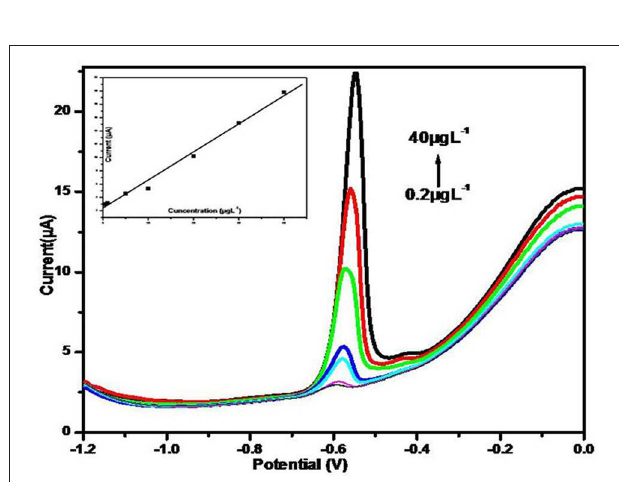
FIGURE 10 | The DPASVs for various concentrations (0.2, 0.5, 1, 5, 10, 20, 30, and 40 µ gL − 1 from bottom to top) of Pb 2 + ions on the ErGO–MWNTs–L-cys/GCE. Inset shows the calibration curve of the Pb 2 + ions. Supporting electrolyte: 0.1M acetate buffer (pH = 4.5) under optimal